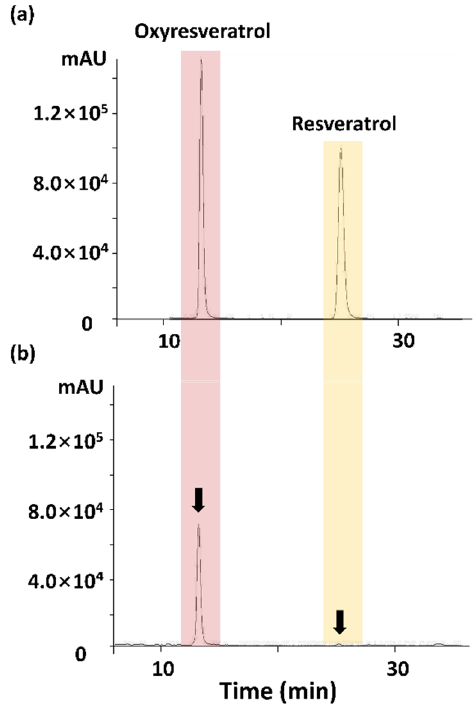
Figure 1. HPLC chromatogram of ( a ) standard solution and ( b ) Mori Ramulus ethanol extracts.